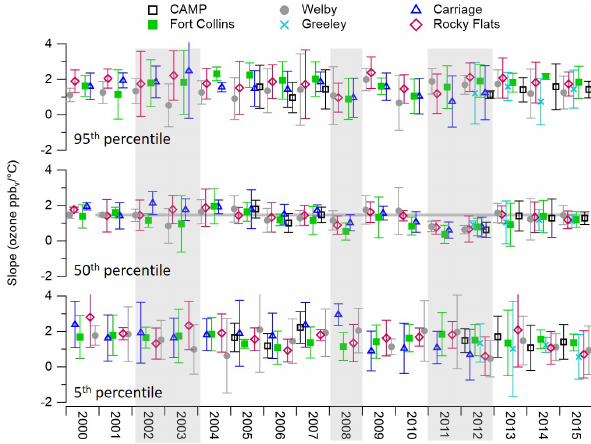
Figure 8. (a) O 3 versus temperature for CAMP, Fort Collins, and Rocky Flats. Hourly O 3 is binned by hourly temperature, with bins containing 51–110 points for O 3 and temperature depending on data availability at a site. The temperature bins typically contained 100– 110 data points (>90% of temperature bins for all sites in all avail- able years). Average O 3 of each bin is plotted versus the average temperature of each bin. Markers and colors represent yearly aver- ages for each site. Error bars were left off for visual clarity, but the 95% confidence intervals around the yearly bin averages are typ- ically <8ppbv. Years were selected based on availability of over- lapping data for multiple sites. (b) One-sided linear regressions of equal point temperature bins for the 5th (red open diamond), 33rd (pink hash), 50th (green open triangle), 67th (blue open square), and 95th (black open circle) percentiles for the CAMP site for 2007 (left), 2012 (middle), and 2015 (right).